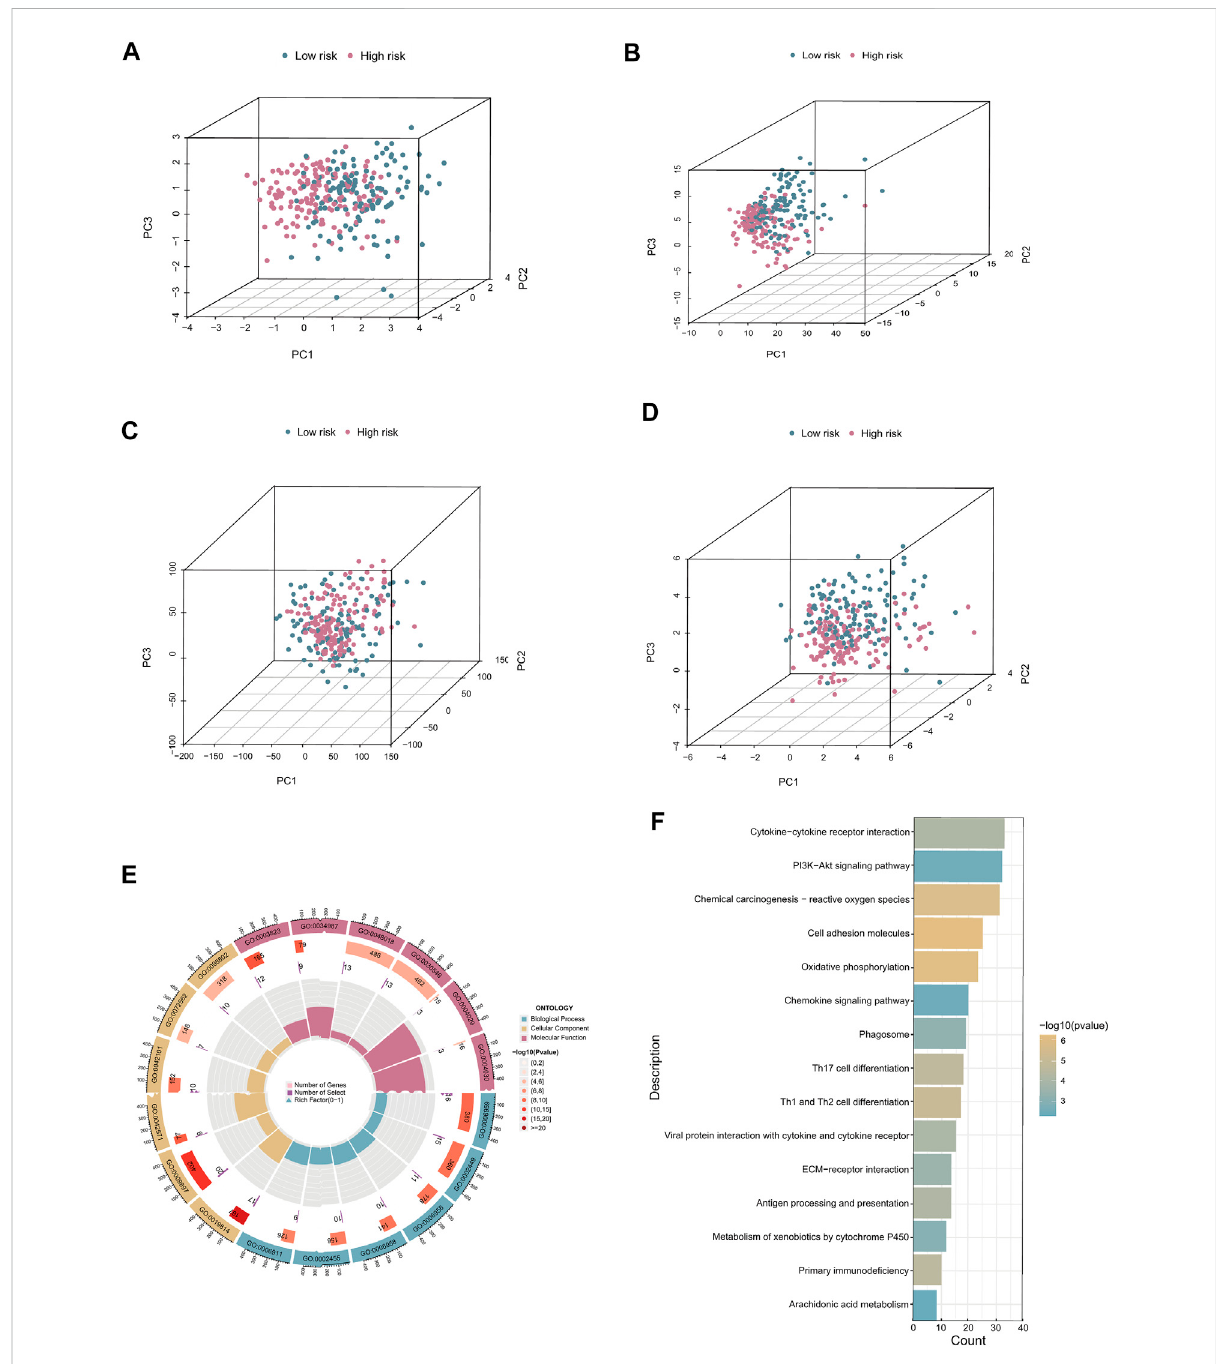
FIGURE 6 PCAand functionalenrichmentanalysis. (A – D) PCAplots based onrisk score,cuproptosis-related lncRNAs, cuproptosis-related codinggenes, and all risk genes. (E) GO biological process, cellular component, and molecular function enrichment. (F) KEGG pathway analysis